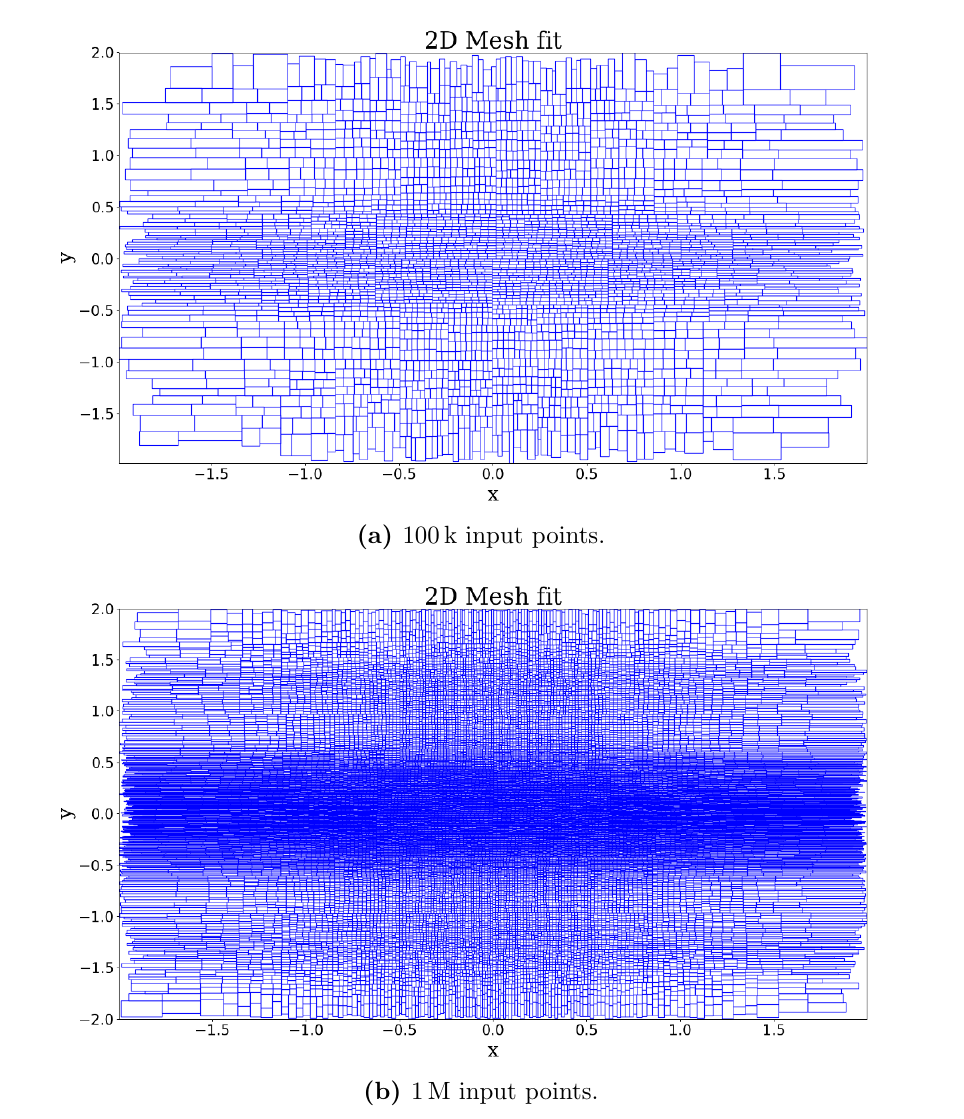
Figure 13. 2D mesh obtained with our algorithm for increasing number of input